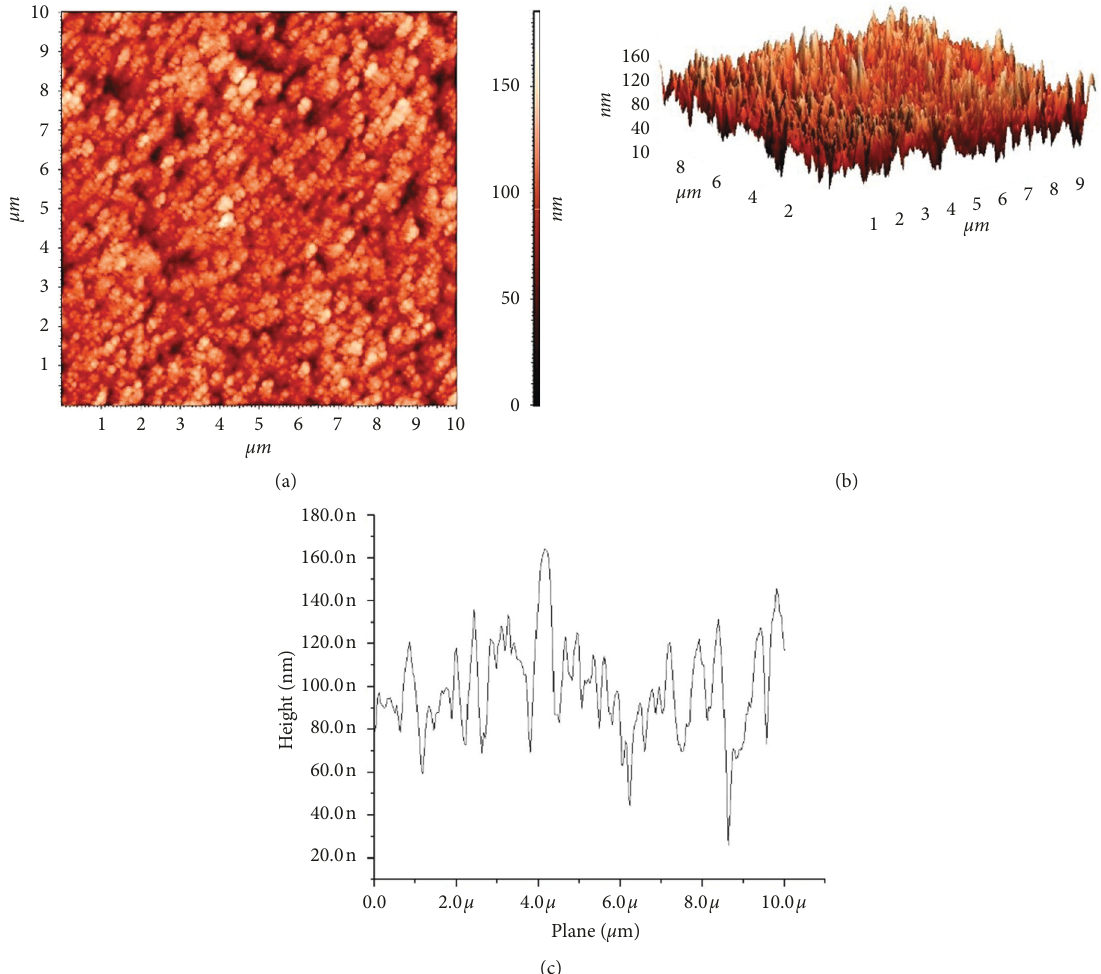
Figure 4: SPM images of samples of irradiated PS doped with carbon: (a) 2D images; (b) 3D images; (c) profiles of the cross sections along the central